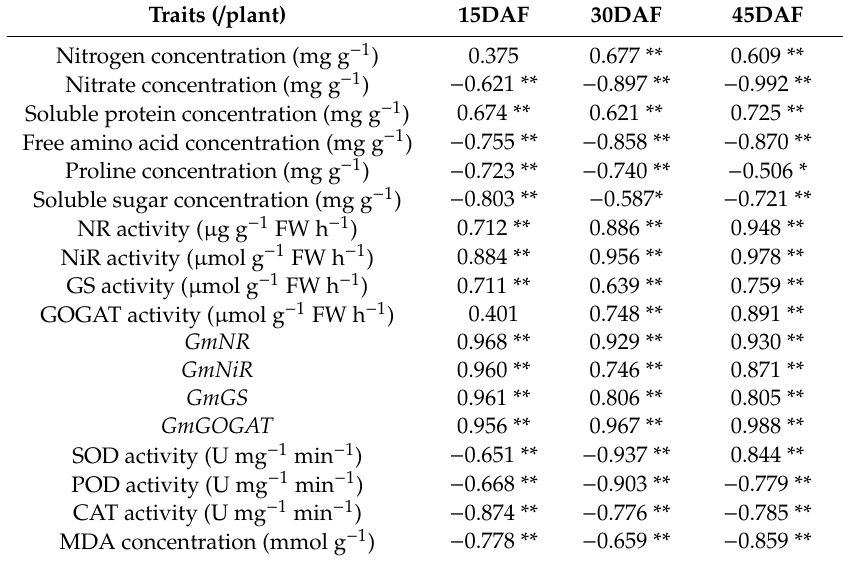
Table 5. Pearson’s correlation of seed weight with physiological parameters during reproductive phases. Traits ( / plant) 15DAF 30DAF 45DAF Nitrogen concentration (mg g − 1